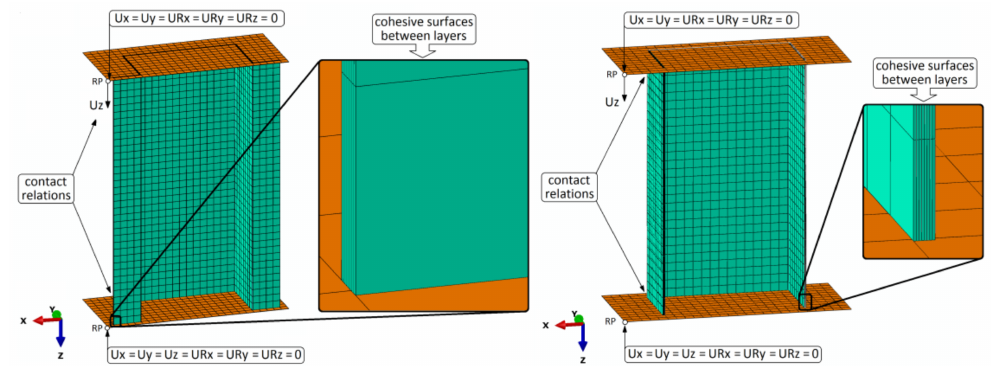
Figure 4. Discrete models of top-hat and channel columns with boundary